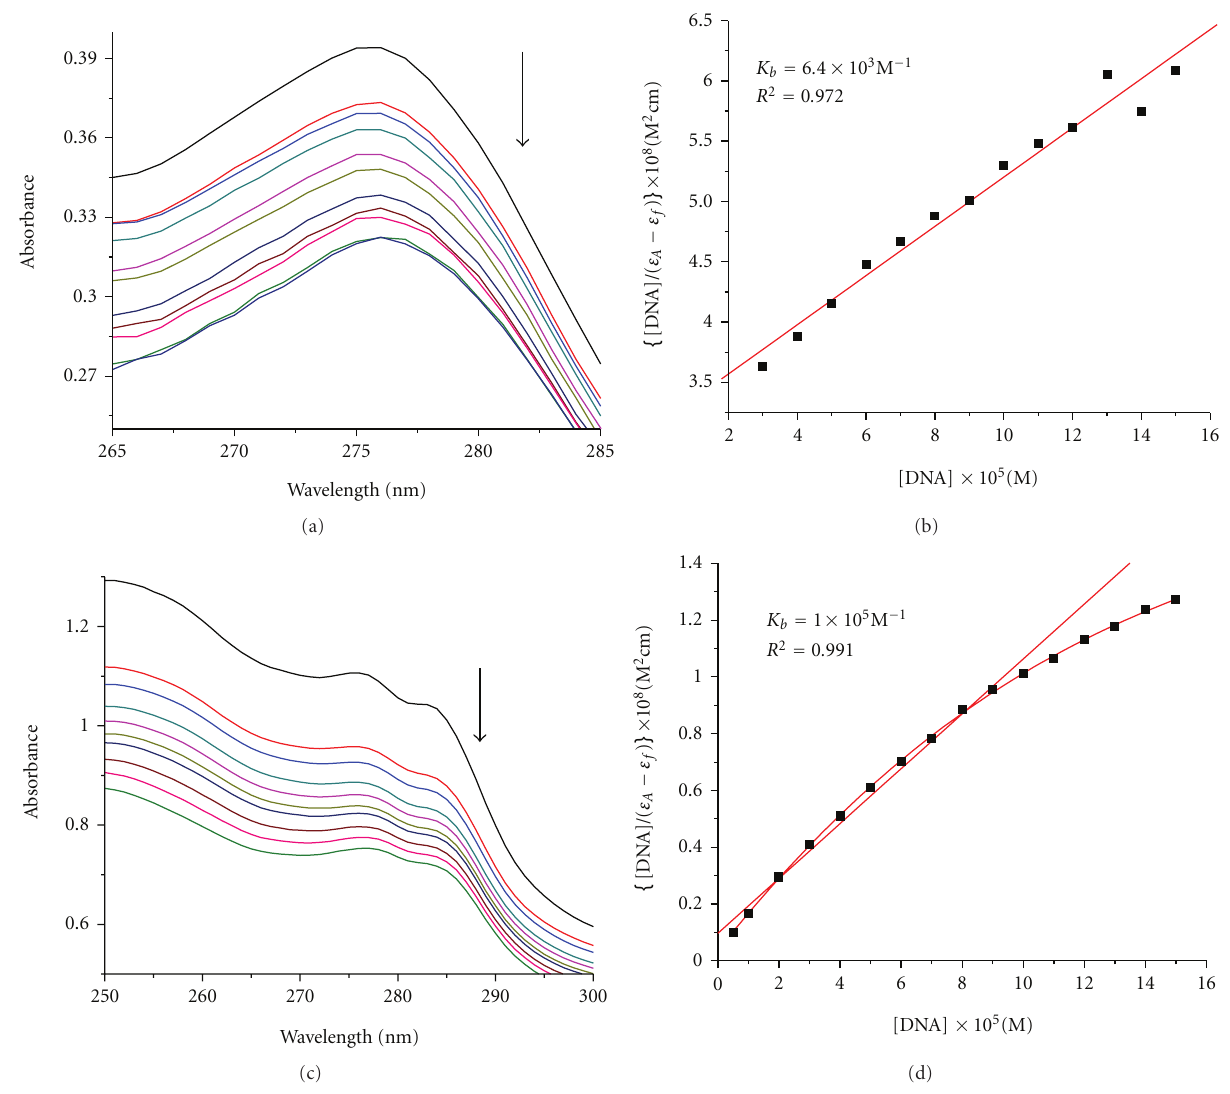
Figure 4: Electronic spectra of the free ligand buobb (a) and the complex Cu(II) (c) in Tris-HCl bu ff er upon addition of CT-DNA. The arrow shows the emission intensity changes upon increasing DNA concentration. [DNA]/( ε a − ε f ) versus [DNA] for the titration of the ligand buobb (b) and the complex Cu(II) (d) with CT-DNA.